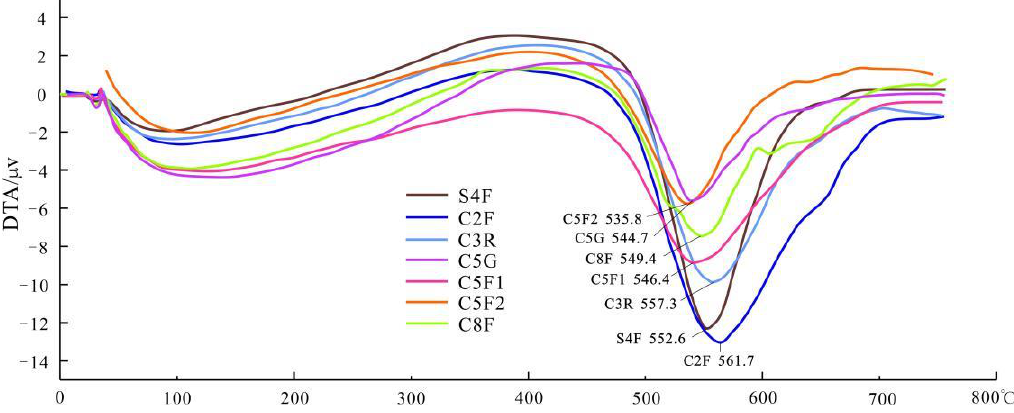
Figure 6. The differential thermal analysis curve of kaolinite; for the exact results, see Table 2. Table 2. Kaolinite rocks’ dehydroxy temperature and heat-absorption valley peak values. Sample